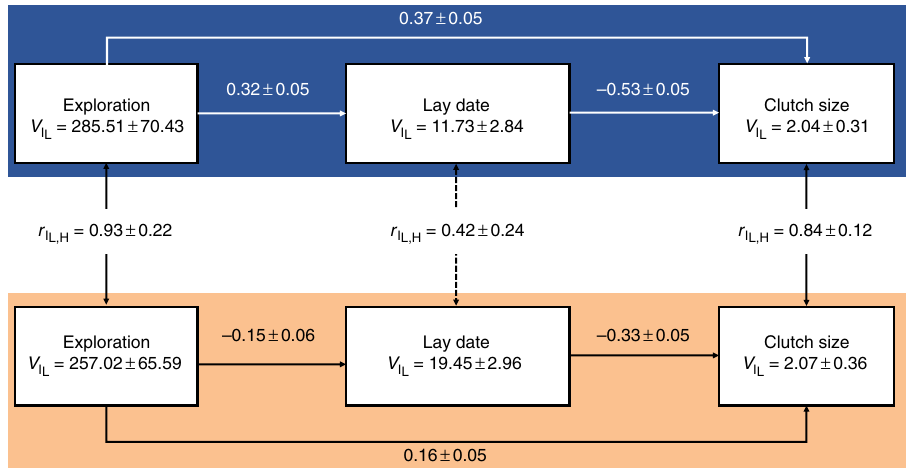
Fig. 3 Path analyses results. Using among-individual correlation matrices to quantify the direct and indirect pathways by which exploratory behavior affected clutch size. Path coef fi cients (±SE) are printed alongside each hypothesized path (directional arrows) for the low-perceived predation level (PPL) (L: blue) and high-PPL (H: orange) treatment plots separately. Treatment-speci fi c among-individual variances ( V ( r ), are printed for each trait. Source data are provided as a Source Data fi le, total sample size is 326 individuals (172 in low PPL, 154 in high PPL), I L ; H ±SE and code is provided in Supplementary Data 1